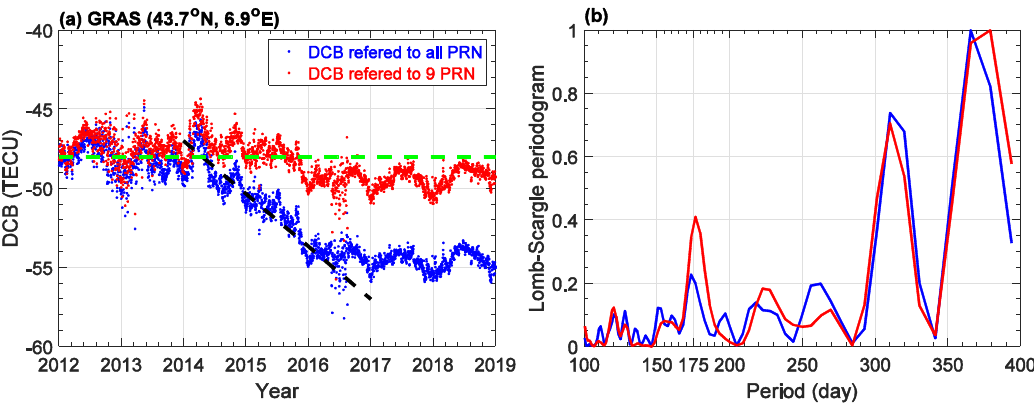
Figure 4. The same as Figure 3a,b, but for the ( a ) receiver DCBs at GRAS station, and ( b ) its Lomb–Scargle periodograms during 2012–2018. The green and black dashed lines indicate the variation trend of the DCBs for reference.